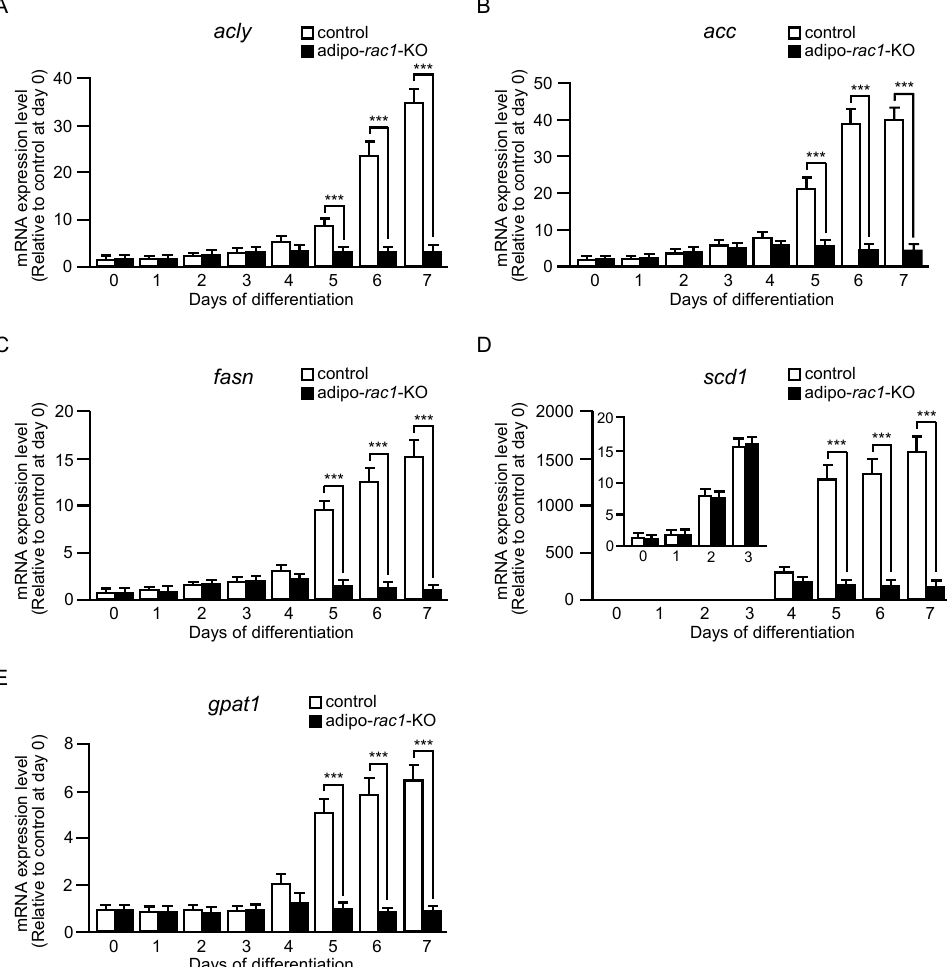
Figure 2. The expression of enzymes for de novo synthesis of fatty acids and triacylglycerol during differentiation of adipose progenitor cells into adipocytes in vitro. The expression of acly ( A ), acc ( B ), fasn ( C ), scd1 ( D ), and gpat1 ( E ) genes during adipogenic differentiation in vitro. Relative mRNA levels in cells derived from control and adipo- rac1 -KO mice were determined by quantitative RT-PCR analysis. Data are shown as means ± S.E. ( n = 3). *** p < 0.001 (Student’s t